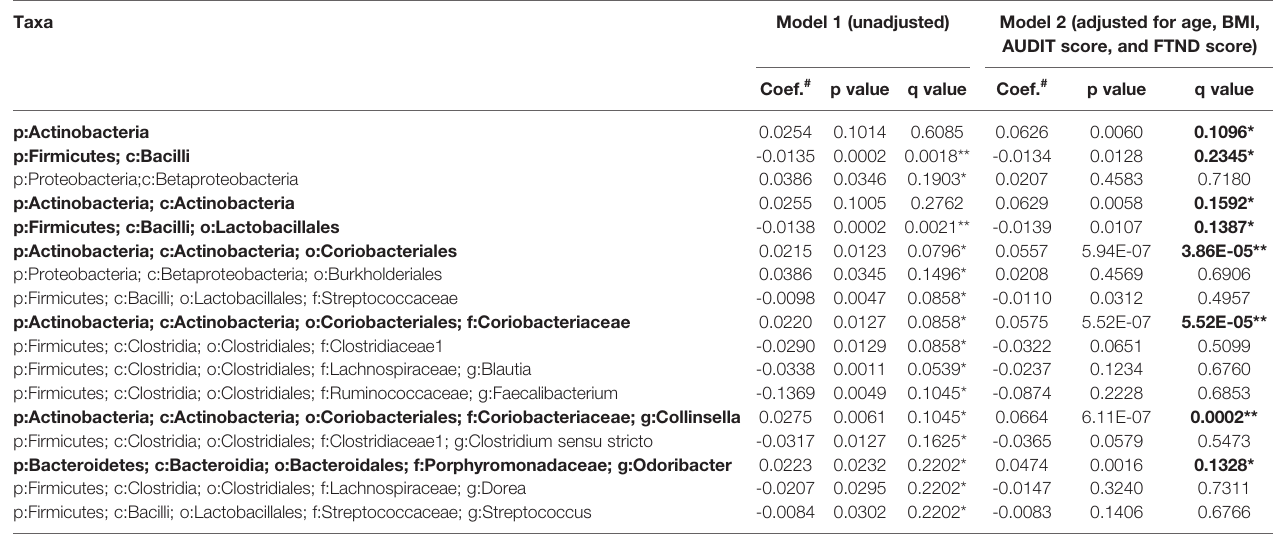
AUDIT score, and FTND score) Coef. # p value q value Coef. #